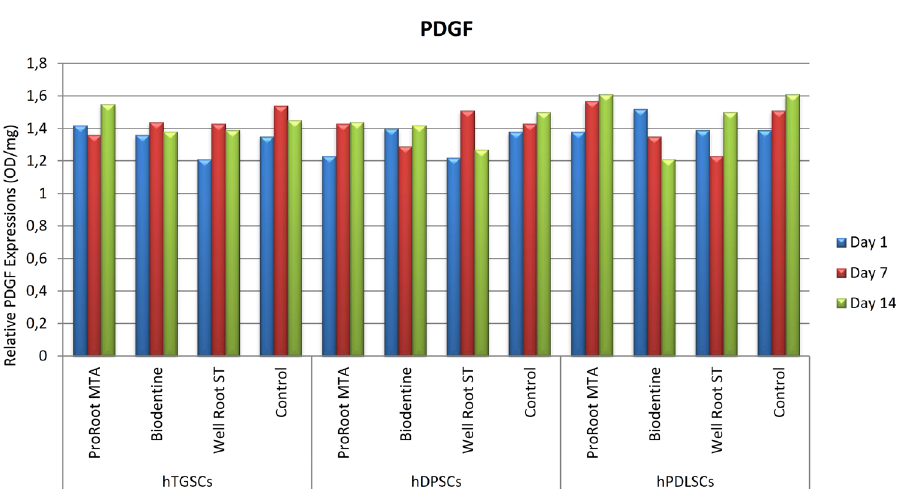
Figure 4- The visualized results of tested materials with ELISA test on different stem cell types for PDGF. hDPSCs: human dental pulp stem cells; hPLSCs: human periodontal ligament stem cells; hTGSCs: human tooth germ stem cells; PDGF: platelet-derived growth factor